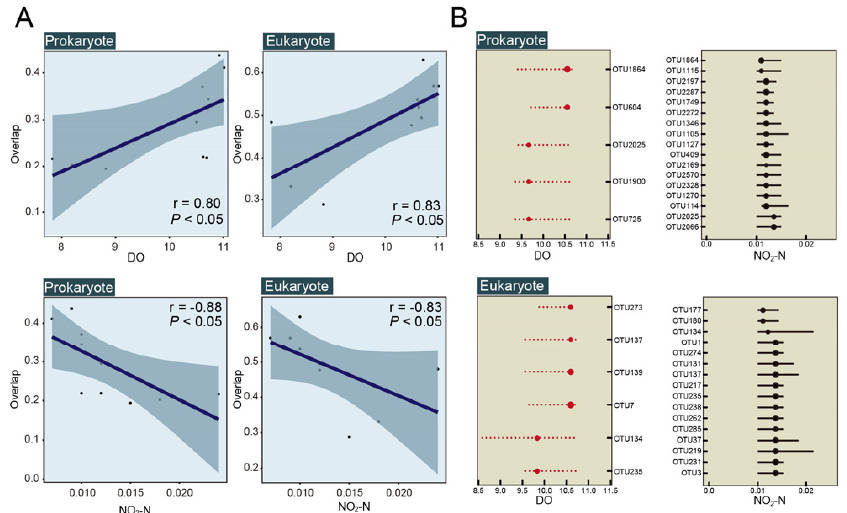
Figure 7. Spearman’s rank correlations between richness overlaps of samples from regions and reference sample and concentration of DO and NO 2 -N for prokaryotes and eukaryotes, respectively ( A ). Threshold indicator taxa analysis (TITAN) of microbial community response to the gradient of DO and nitrite nitrogen (NO 2 -N) ( B ). Black symbols correspond to negative (z − ) indicator taxa (i.e., abundance decreases), while red corresponds to positive (z+) indicator taxa (i.e., abundance increases). Symbols are scaled in proportion to z scores. Horizontal lines overlapping each symbol represent 5th and 95th percentiles among 500 bootstrap